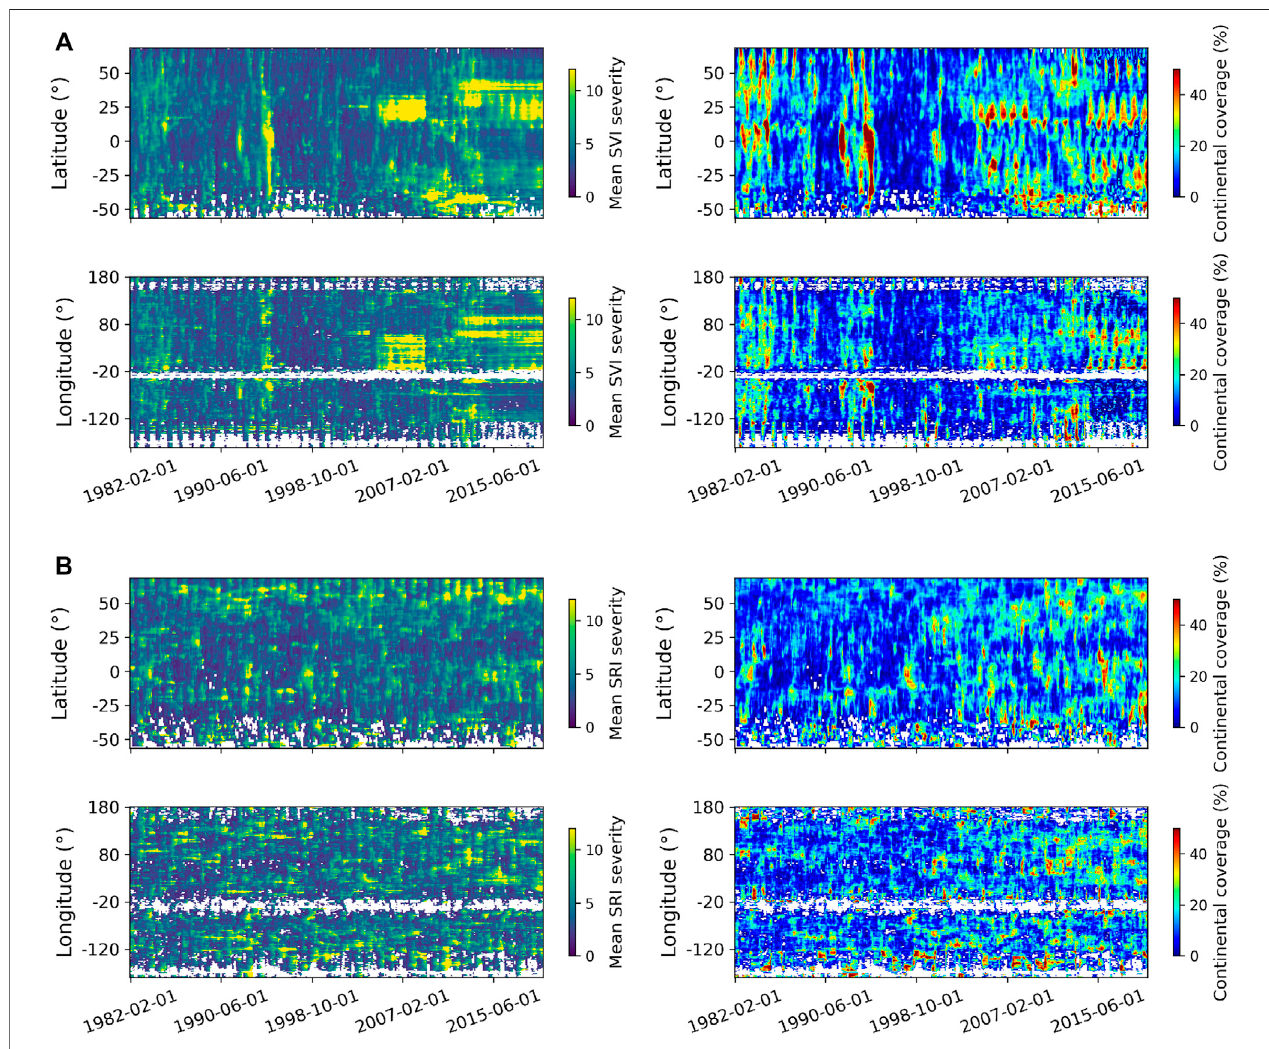
FIGURE13| Heatmapsofmean3-monthSVIseverity (A) and3-monthSRIseverity (B) bylatitudeandlongitudewiththecorrespondinglatitudinalandlongitudinal continental coverage (right panels).